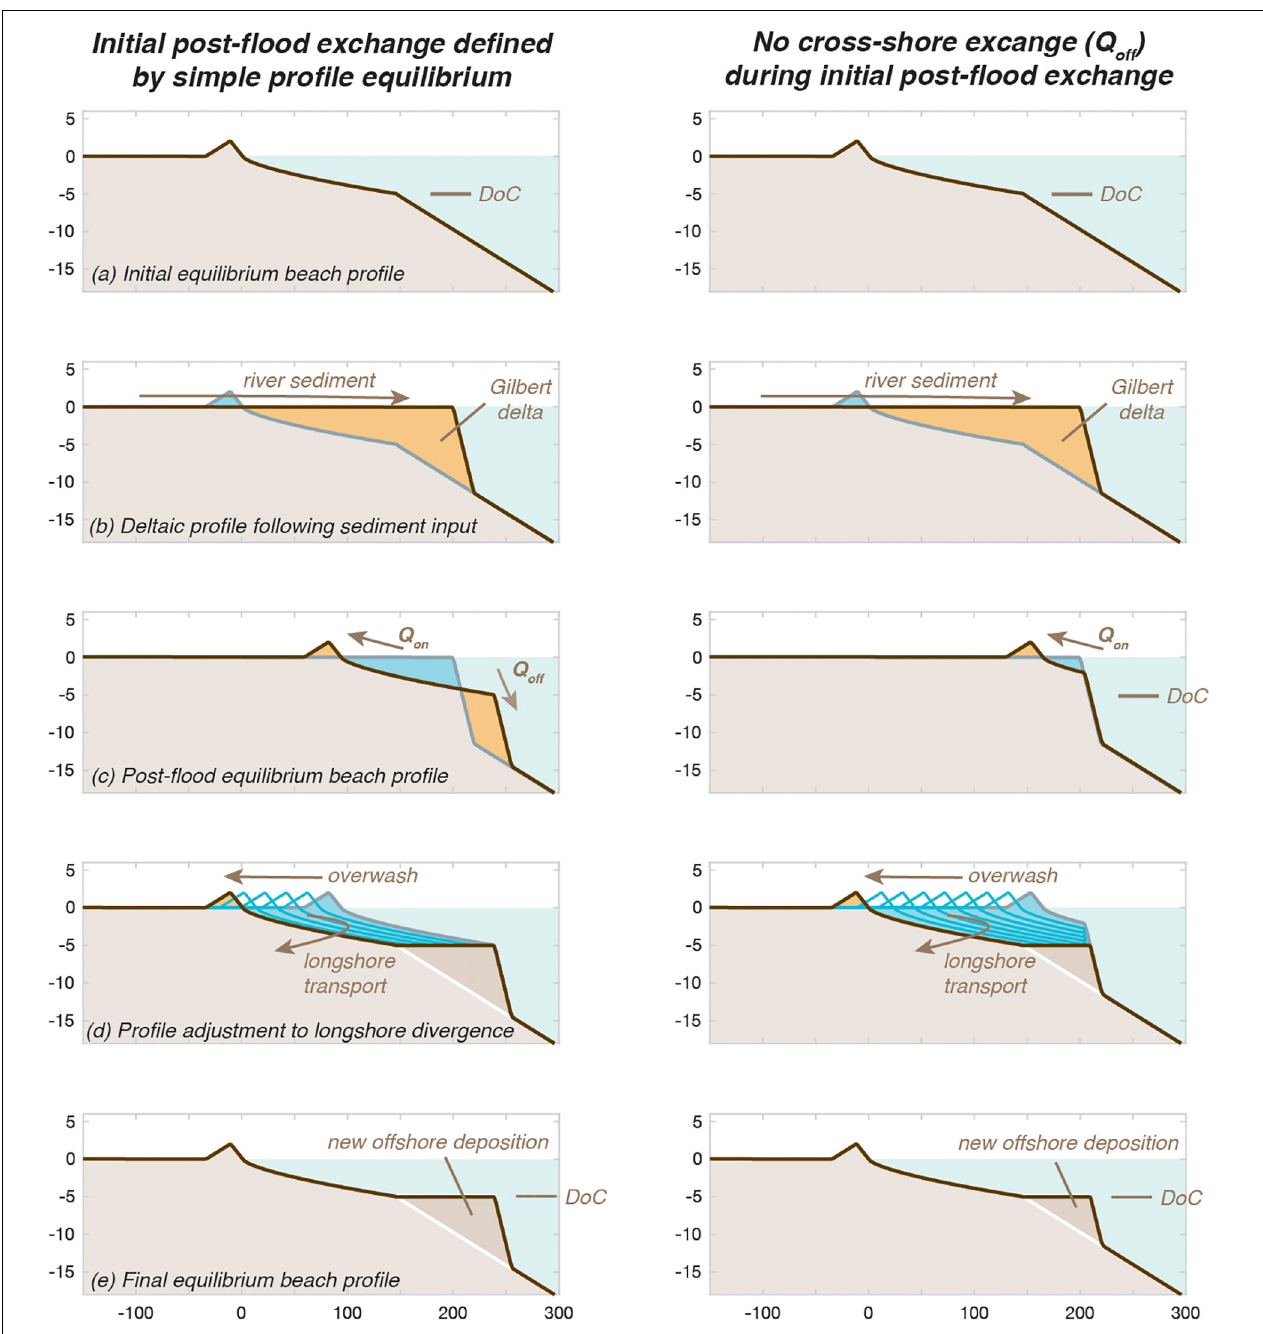
FIGURE 12 | Geometric evolution of a river mouth profile for a Gilbert-like delta deposit using a simple rules-based morphodynamic model with two different conditions. The initial profiles (a) are modified by rules that define the profile shape(s) and sediment transfers for different stages of delta evolution (b–e) . The differences in the model output are caused by different rules defining sediment exchanges during the initial post-flood profile evolution (c) . For the simple equilibrium condition (left-hand column), the delta profile evolves toward an equilibrium beach profile without constraining the direction or rate of cross-shore sediment transport. The second condition evolves toward an equilibrium profile without offshore transport (right-hand column). Parameters for these models are provided in Table 2 .